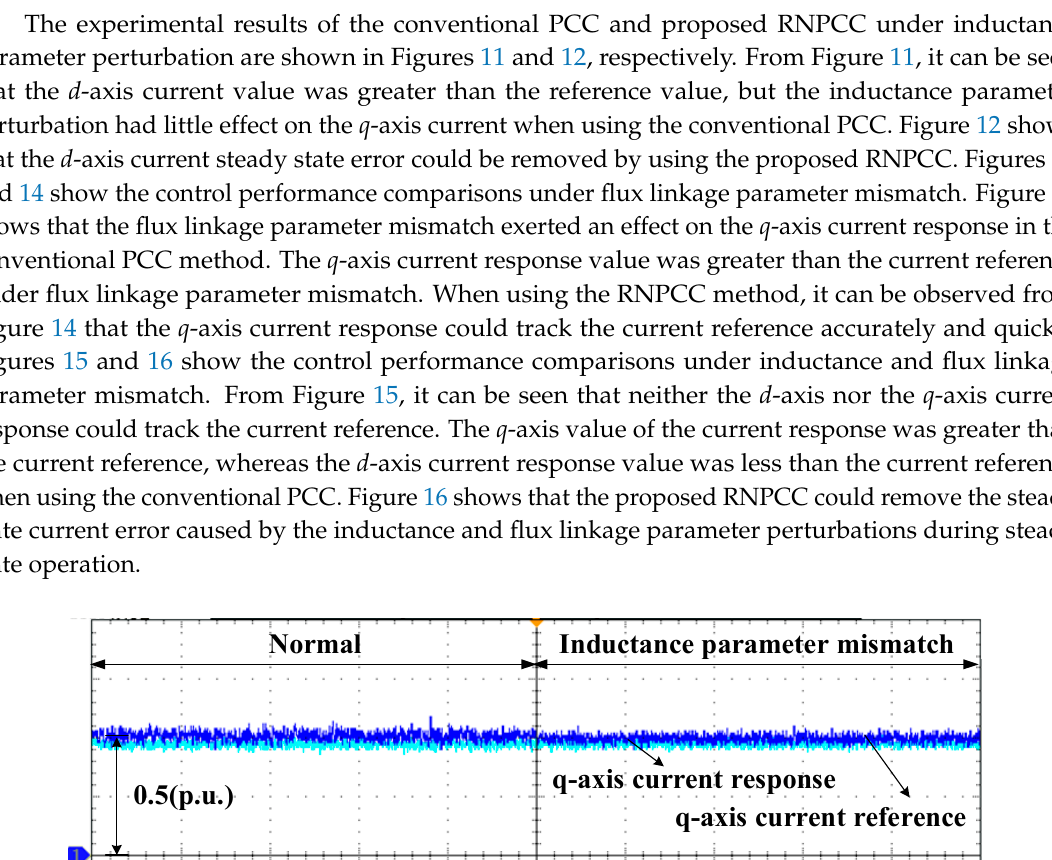
Figure 11. Experimental results of the conventional PCC method under inductance parameter perturbation.